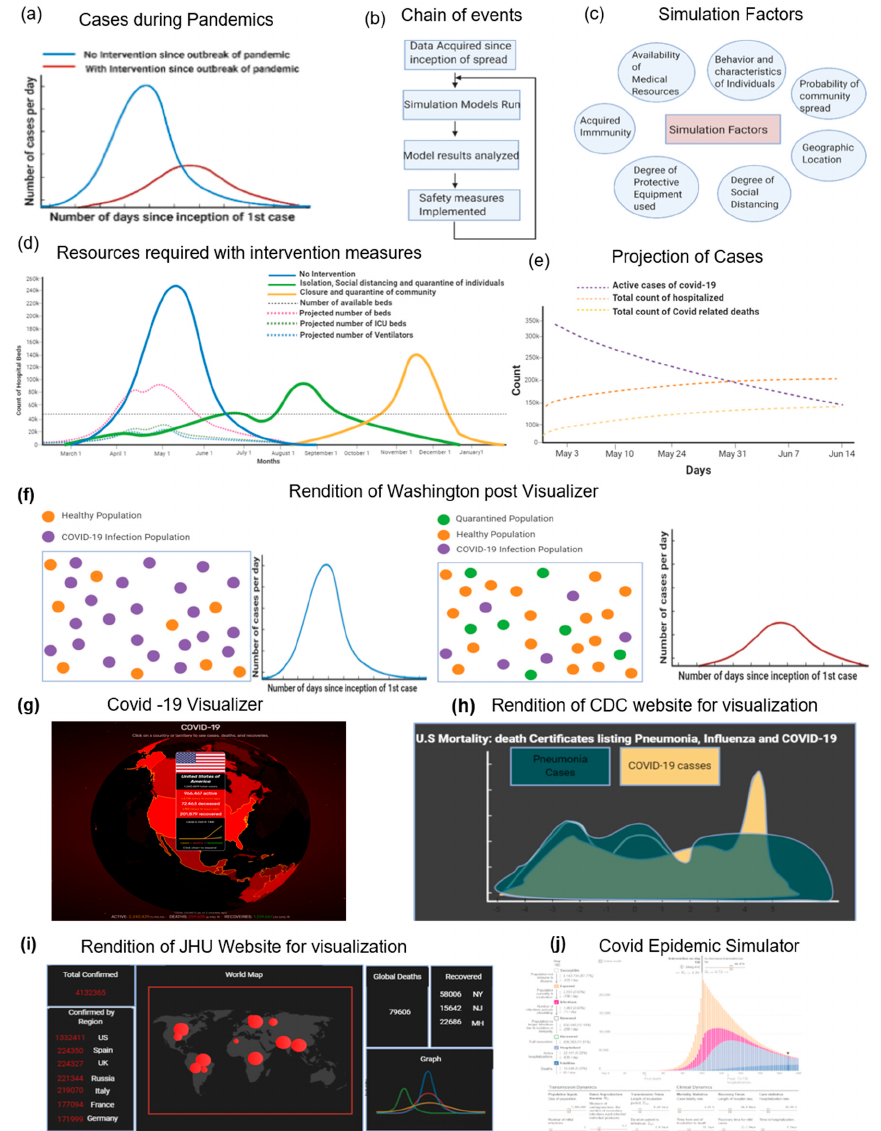
Figure 6. Simulation tools for COVID-19 pandemic modeling and predictions. ( a ) Comparison of epidemic curves with (red) and without (blue) intervention, as suggested by the CDC; ( b ) The sequence of events initiated by utilizing the results of a simulator is shown; ( c ) The main factors considered for the COVID-19 simulators, such as measures of social distancing and probability of community spread; ( d ) Comparison of projected curves resulting from various simulations that cover different scenarios of social distancing, for the months of March to January in the US; ( e ) Projection of the number of active cases, those hospitalized, and deaths from COVID-19, simulated between May 3 to May 31 in the US; ( f ) A rendition of the billiards balls model by the Washington Post, to illustrate the benefits of social distancing. (LEFT) Simulation rendition which depicts effects caused if social distancing is not followed. (RIGHT) Simulation rendition, if social distancing is followed. The simulation renditions are followed by epidemic curve graphs; ( g ) A platform provided by the COVD-19 Visualizer website, which updates the number of cases worldwide in real-time; ( h ) A rendition of the comparison of mortality cases related to COVID-19, influenza, and pneumonia in the US, as visualized by the CDC; ( i ) A rendition of the various visualizations on COVID-19 spread worldwide, provided by the Johns Hopkins website; ( j ) Screenshot of an interactive simulator involving various metrics that predicts the severity of COVID-19